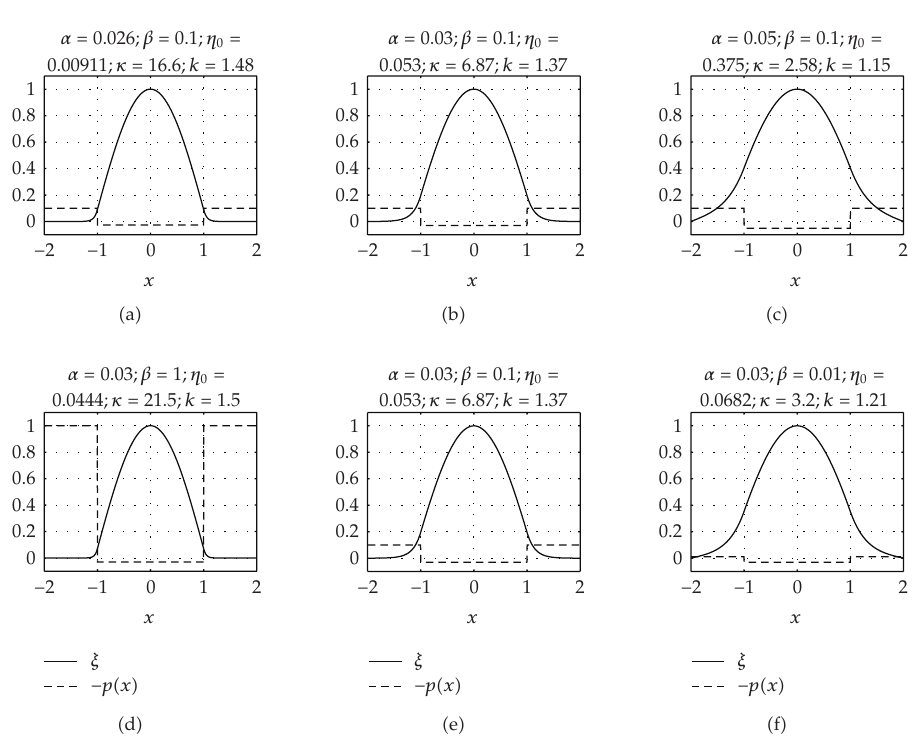
Figure 1: Spreading of the wave . The automatic domain is located on (cid:6) − 1 , 1 (cid:7) and the FitzHugh-Nagumo parameters (cid:3) (cid:8) 0 . 05 and γ (cid:8) 0 . 5 are used. Depicted are the function ξ in (cid:3) 2.6 (cid:4) (cid:3) giving the spatial shape of the approximative solution (cid:3) 3.28 (cid:4)(cid:4) and the automaticity function in (cid:3) 2.2 (cid:4) for di ff erent values of α and β . The corresponding critical di ff usion coe ffi cient η 0 and the values of k (cid:8) in the function ξ are indicated as well. Upper row : increasing automaticity α of the automatic cells makes the wave spread further into the surrounding tissue. Lower row : decreasing stability β of the normal cells makes the wave spread further into the surrounding